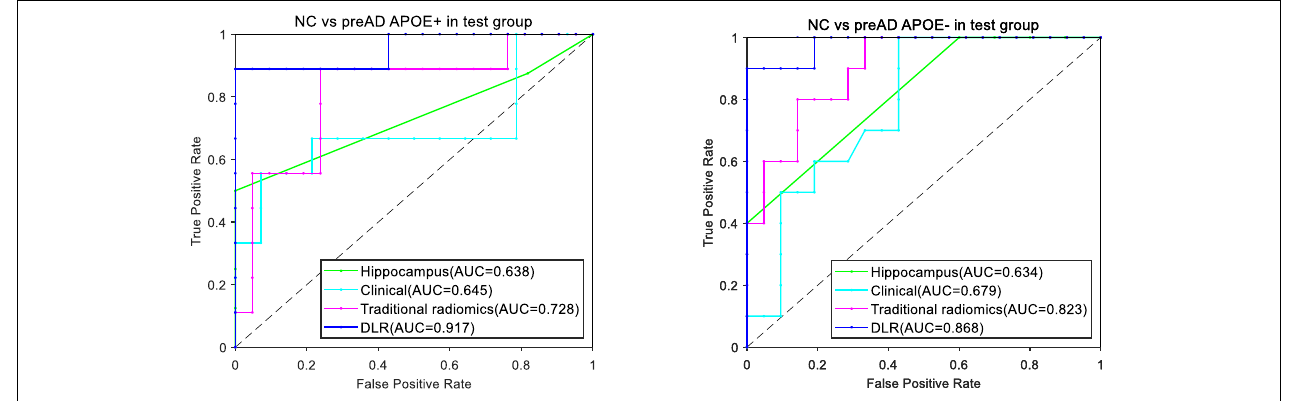
FIGURE 5 | ROC curves of the four models between NC and preAD APOE+ groups (left) and between NC and preAD APOE – groups (right) .